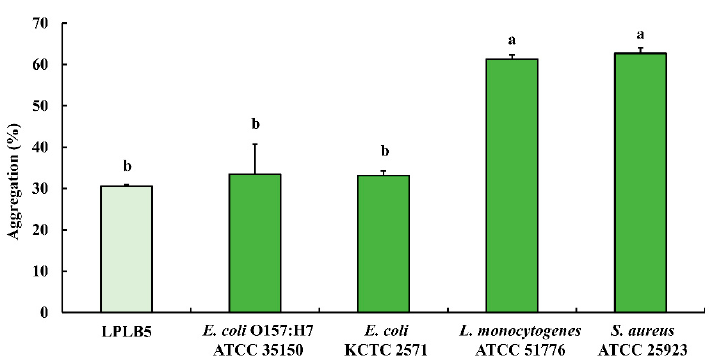
Figure 6. Auto- and co-aggregation ability of LPLB5. The absorbance of the bacterial suspension at was measured at 600 nm and that of the upper phase was measured at 600 nm again after incubation at 37 °C for 4 h. The results represent the mean ± SEM, with n = 3. The different letters on the error bars indicate statistically significant differences between the groups ( p < 0.05).